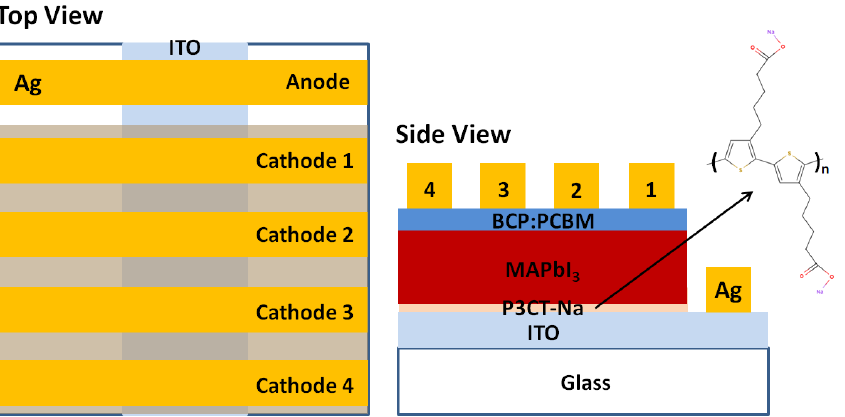
Figure 1. A top view and cross-sectional view of the device